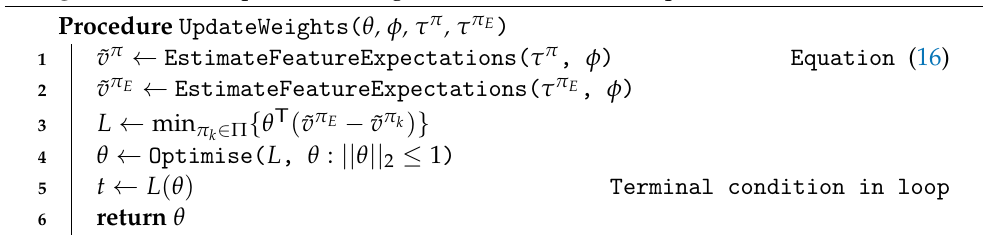
Algorithm 2: Excerpt from the algorithm in [42], with adapted